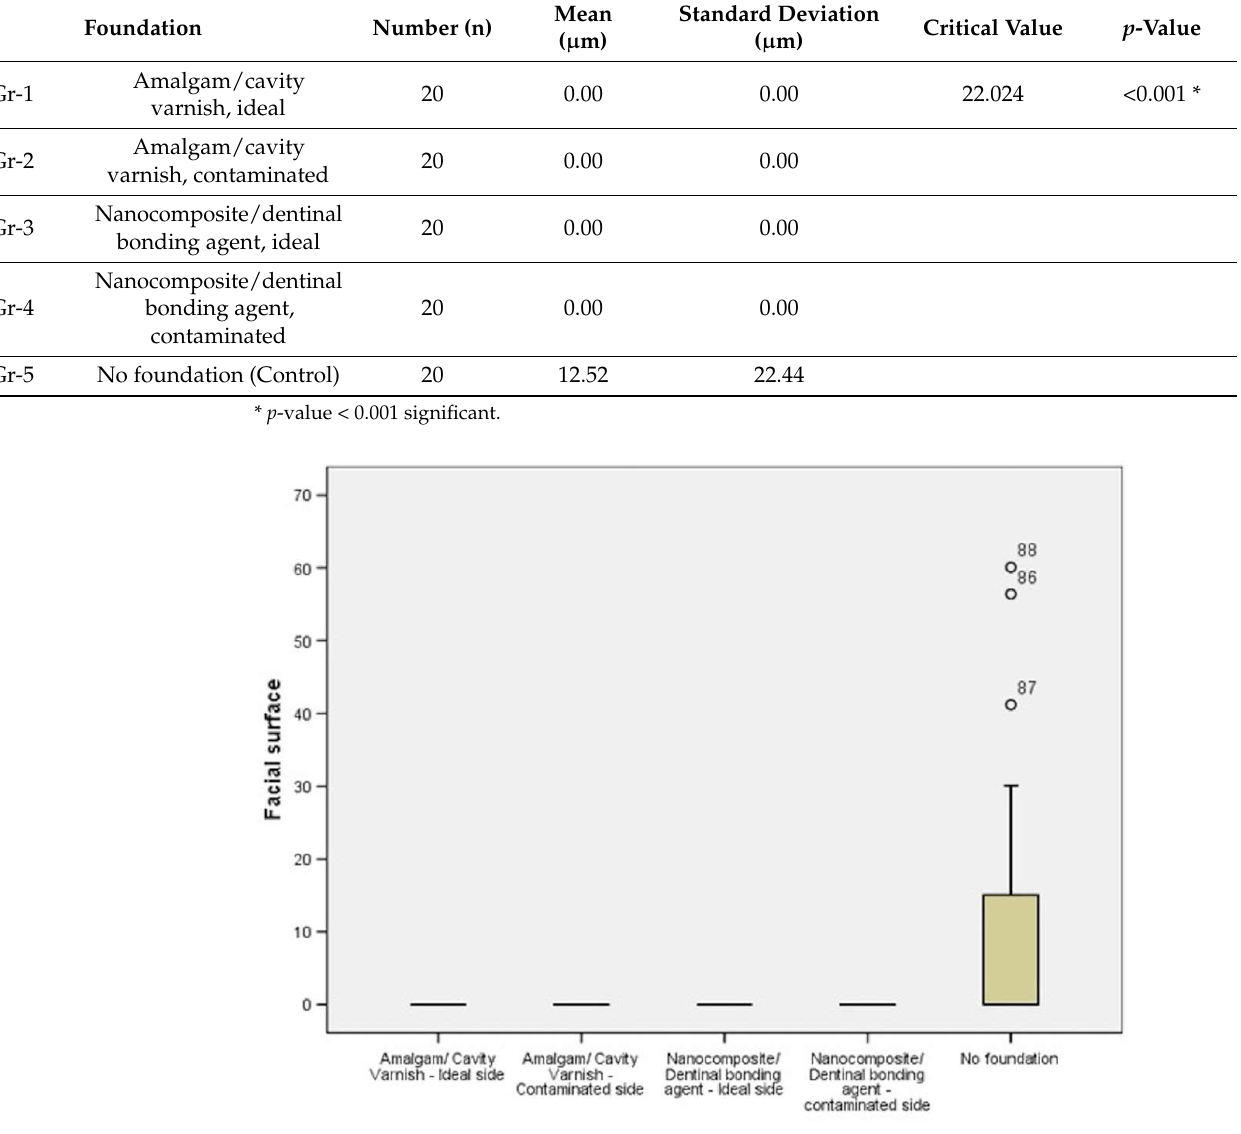
Figure 6. Box plot showing comparison of microleakage between different crown foundation materials on facial surface.